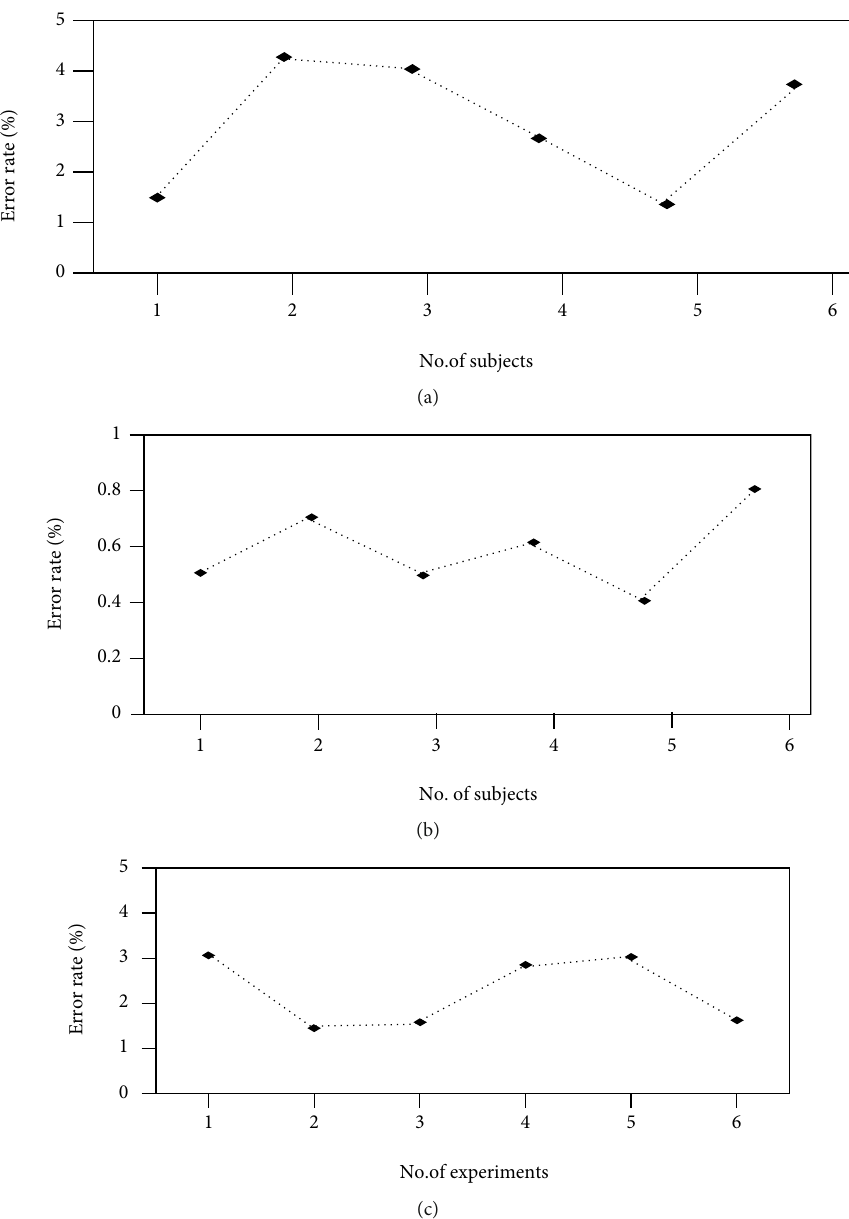
Figure 6: (a – c) Error rate for a developed system for (a) heart rate, (b) body temperature, and (c) room